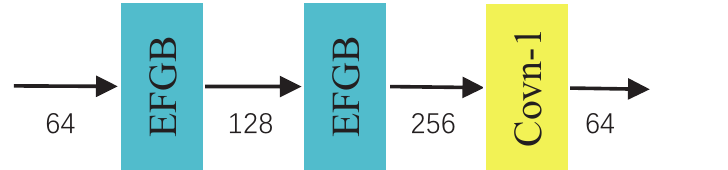
Figure 7. The structure of modified SIRU. 64, 128, 256 represent the channel numbers of feature maps.